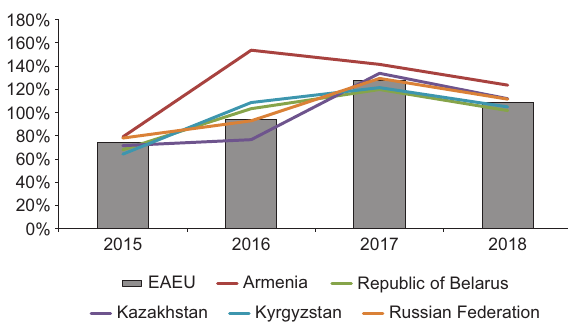
Fig. 1. Growth rates of the EAEU mutual merchandise exports.